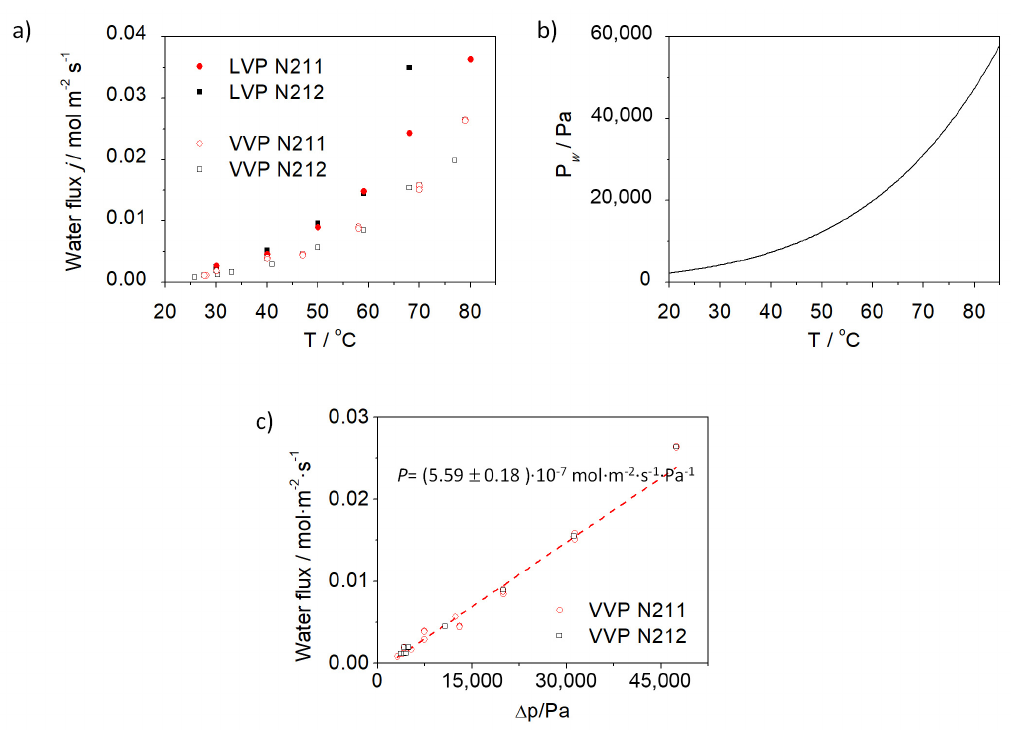
Figure 4. ( a ) Water permeation flux through N211 and N212 film under liquid–vapor permeation (LVP) and vapor–vapor permeation (VVP) conditions as a function of the temperature; ( b ) Water vapor pressure as a function of the temperature; ( c ) Water flux measurements for VVP in N211 and N212 film under natural convection of